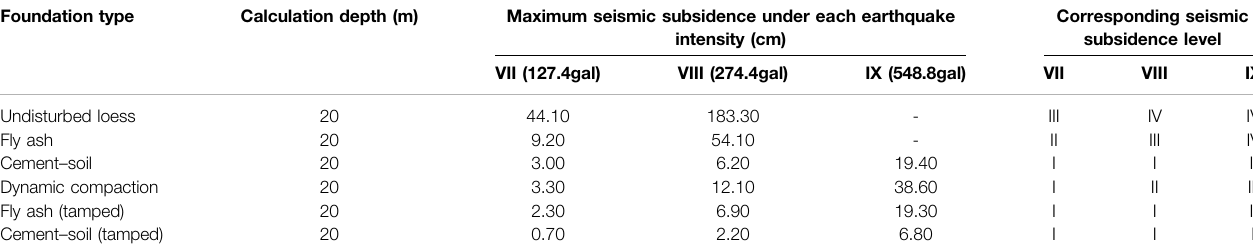
TABLE 4 | Prediction results of seismic subsidence of loess fi eld with different foundation treatment measures. Foundation